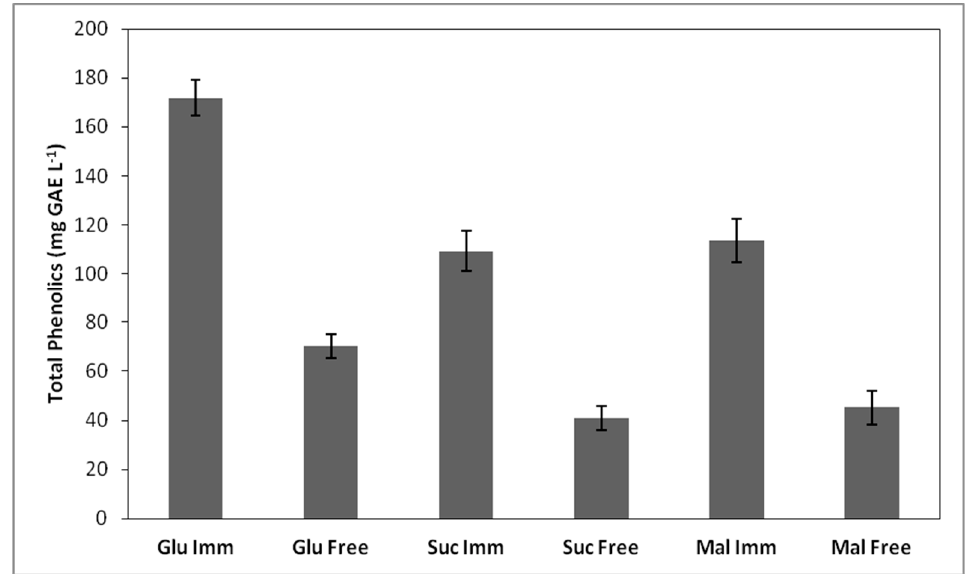
Figure 3. Total phenolic content (mg GAE L − 1 ) of the produced alcoholic beverages at 21 °C.